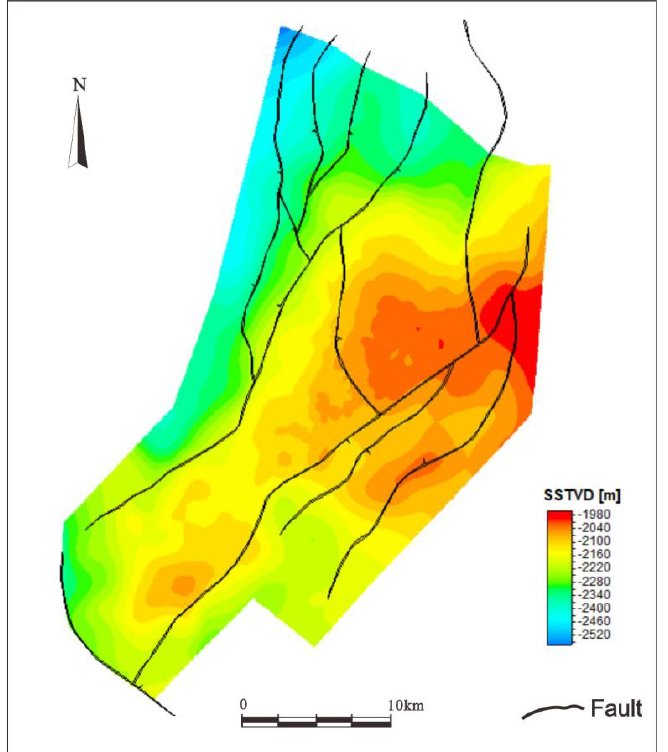
Figure 2. Structural map of the North Truva Oilfield.